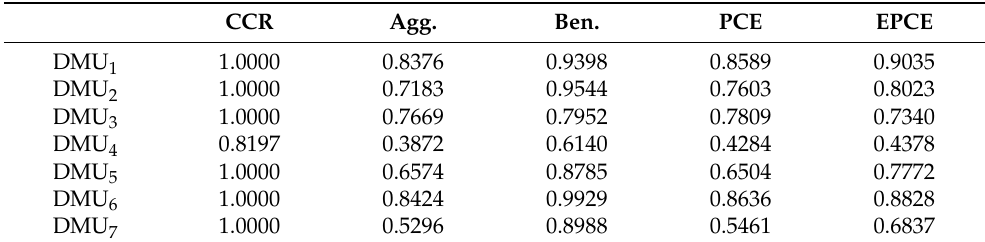
Table 5. The efficiency scores of the models.